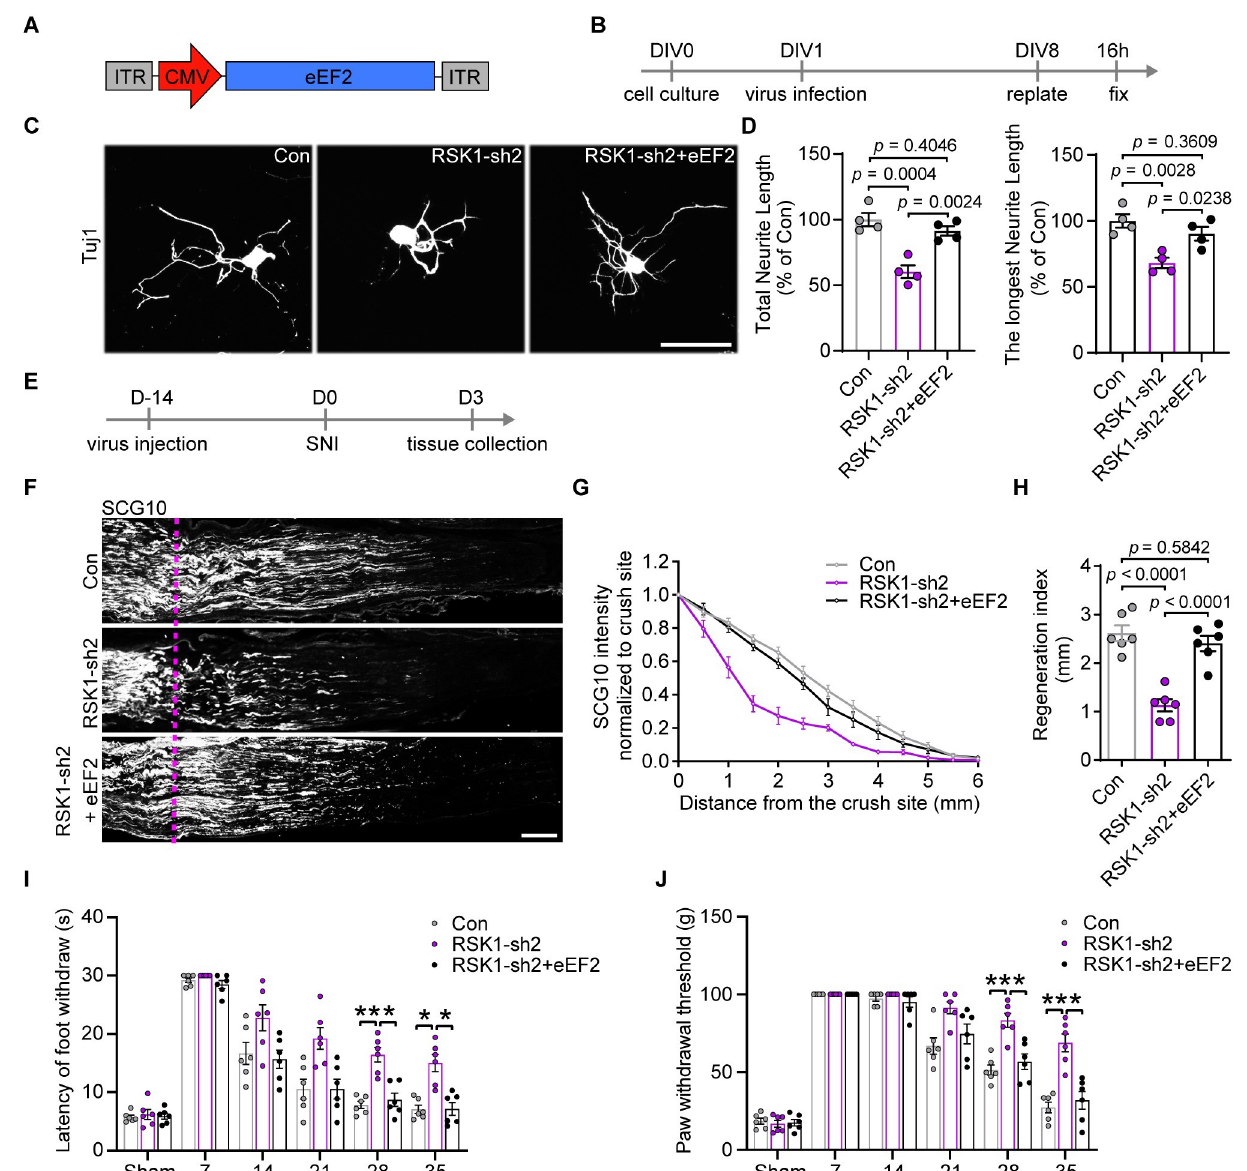
Fig 5. Overexpression of eEF2 rescues the inhibitory effect of RSK1 KD. (A) A schematic representation of the AAV2/8-CMV-eEF2 (eEF2) vector utilized in eEF2 overexpression experiments. (B) Timeline for RSK1 KD and/or eEF2 overexpression in DRG neurons at DIV1. (C) Representative images of cultured DRG neurons infected with control AAV (Con), AAV to knock down RSK1 (RSK1-sh2), or AAVs to knock down RSK1 and overexpress eEF2 (RSK1-sh2+eEF2). Scale bar, 100 μ m. (D) Quantification of the total and the longest neurite outgrowth per neuron relating to (C) (mean ± SEM, 1-way ANOVA, Tukey post hoc test, n = 4 biologically independent experiments, approximately 50 cells/experiment on average). (E) Timeline for AAV infection in vivo and SNI. (F) Representative longitudinal sections from injured sciatic nerves. The crush site is indicated by a purple dotted line. Scale bar, 500 μ m. (G) Normalized SCG10 intensity plotted in function of the distance from the crush line ( n = 6 rats per group). (H) Axon regeneration in injured rats was quantified by regeneration indices obtained from SCG10 immunostaining on day 3 after crush injury (mean ± SEM, 1-way ANOVA, Tukey post hoc test, n = 6 rats per group). (I, J) Assessment of the recovery of thermal (I) or mechanical (J) sensory function after SNI in rats infected with RSK1-sh2, RSK1-sh2+eEF2, or control AAV2/8 (mean ± SEM, 2-way ANOVA, Bonferroni post hoc test, n = 6 rats per group). The data underlying all the graphs shown in the figure are included in S1 Data. DIV1, 1 day in vitro; KD, knockdown; RSK1, ribosomal S6 kinase 1; SEM, standard error of the mean; SNI, sciatic nerve injury.